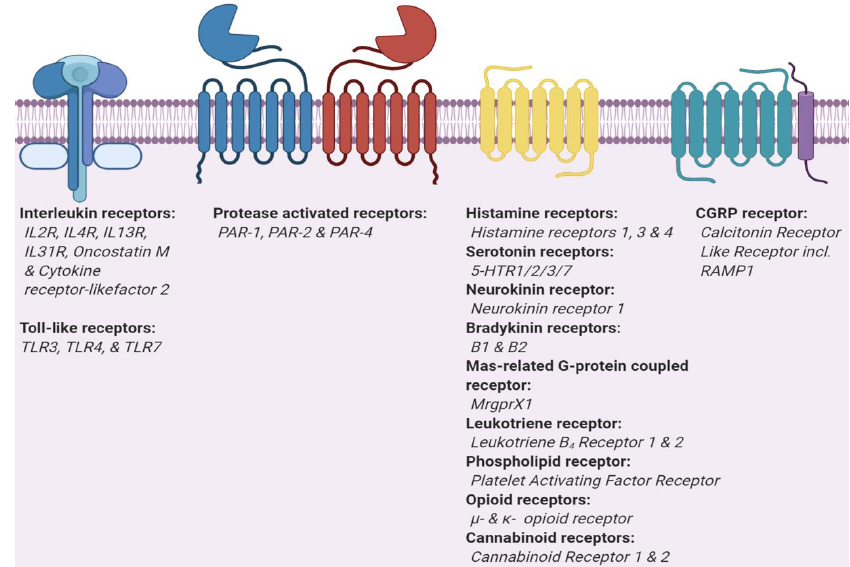
Figure 2. Two main types of itch receptors. Itch receptors can be grouped in two main types, interleukins and G protein-coupled receptor (GPCRs). Toll-like receptors (TLRs) and interleukin receptors (ILRs) are part of the Interleukin-1 Receptor/Toll-like Receptor Superfamily. GPCRs are divided into three sub-types, classic GPCRs, protease activated receptors that dimerize [41,42], and GPCRs which require a receptor activity modifying protein (CGRP).